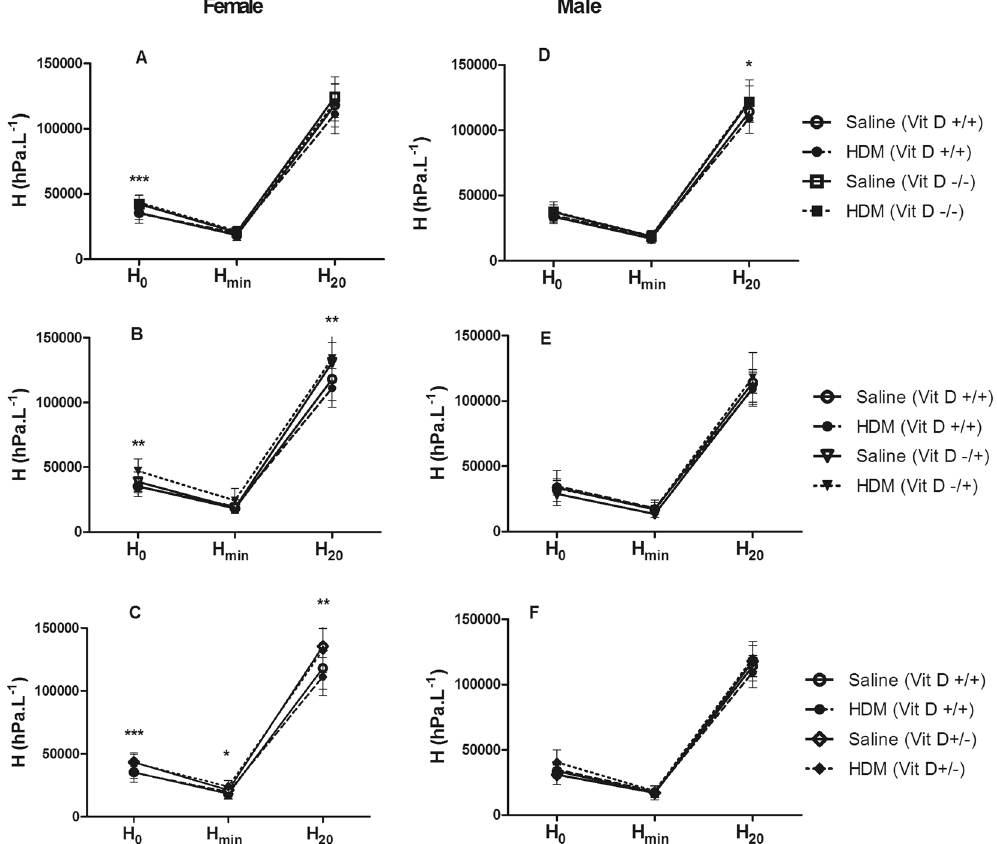
Figure 3. Tissue elastance (H) at 0 cmH 2 O Prs (H 0 ), 20 cmH2O Prs (H 20 ) and the minimum (H min ) for female ( A – C ) and male ( D – F ) saline and house dust mite (HDM) exposed mice that were vitamin D replete (Vit D + / + ), whole-life vitamin D deficient (Vit D − / − ; A , D ), in utero vitamin D deficient (Vit D − / + ; B , E ) or post-natal vitamin D deficient (Vit D + / − ; C , F ). Data are presented as mean (SD), n = 9–13 for each group. * p < 0.05; ** p < 0.01; *** p <